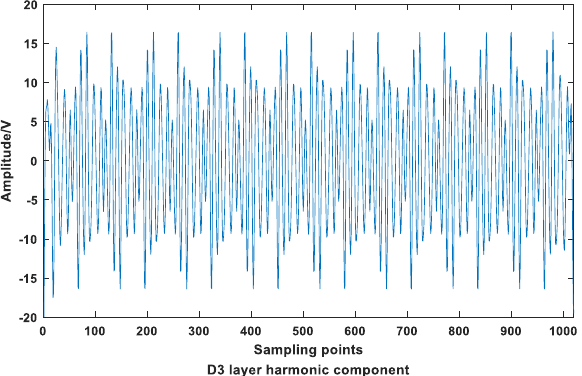
Figure 8. D3 layer reconstruction waveform. Figure-8. D3 layer reconstruction waveform. Figure-8. D3 layer reconstruction waveform.